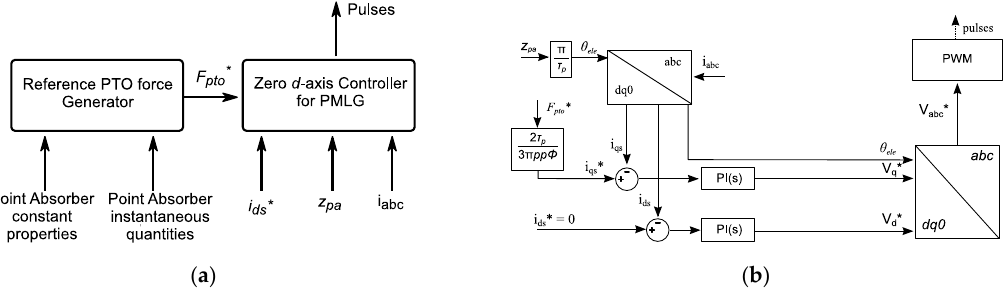
Figure 7. Block diagrams of ( a ) generator-side control strategy and ( b ) zero d-axis controller.